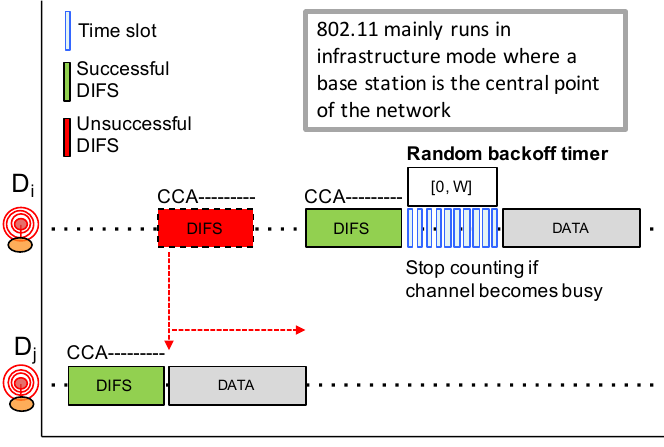
Figure 10. IEEE 802.11